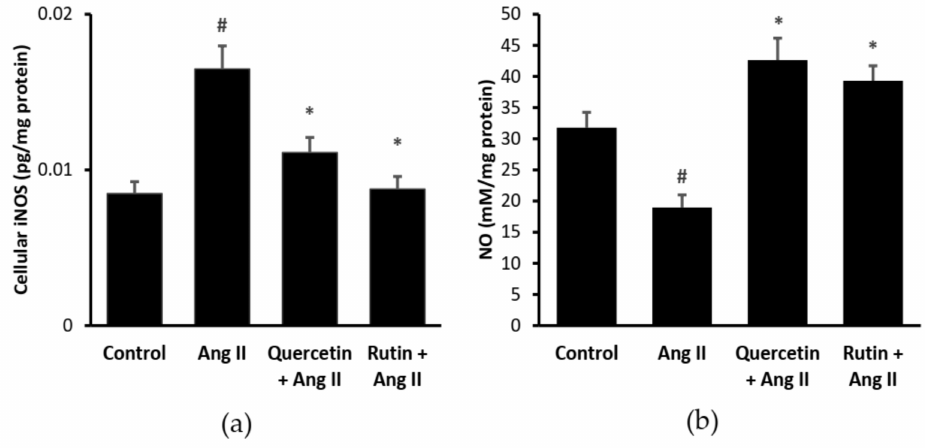
Figure 4. ( a ) Cellular inducible nitric oxide synthase (iNOS) and (b) NO levels in different groups. # p < 0.05 vs. control group, * p < 0.05 vs. Ang II alone treated cells. Data were analyzed by a one-way ANOVA followed by a Tukey post hoc test and are represented as the mean ± SEM ( n =